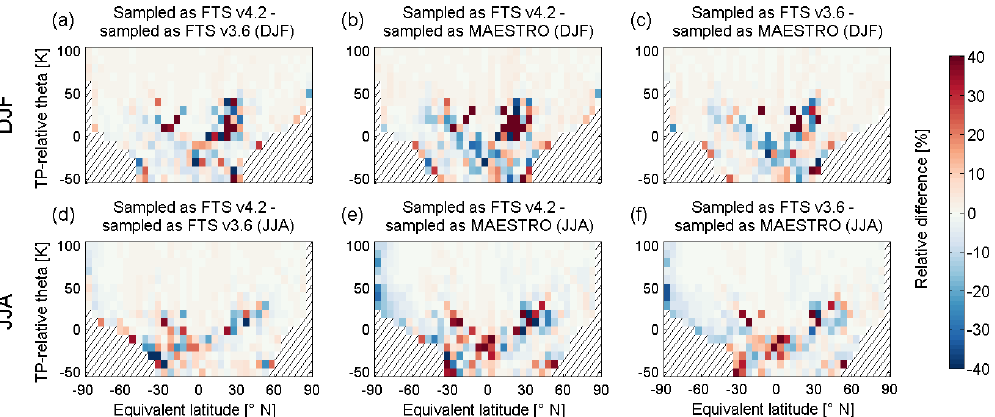
Figure 3. Intercomparisons of the CMAM39-SD model water vapour simulation, subsampled to the times and locations of the ACE- FTS v4.2, ACE-FTS v3.6, and MAESTRO measurements in order to assess the regions where the impact of the instruments’ sampling pattern is largest. Panels (a–c) correspond to the comparisons for DJF, while panels (d–f) show comparisons for JJA. Each plot title gives the two subsampled climatologies compared, with differences given as a relative difference (%). These differences are calculated as the first subsampled model climatology minus the second and divided by the average of the two. Note the addition of hatching to the plots where there are no data available. Table 1. Average magnitude of the relative differences ( | δr i,j | ) in water vapour between the model and measurement climatologies over select regions of the UTLS. The approximate vertical region is denoted alongside the vertical range, with UT standing for upper troposphere and LS for lower stratosphere. The regions reflect where the model displays consistently higher or lower water vapour than the instruments. Values are bold if the instrument climatology yields more water vapour than CMAM39-SD for that period. In addition, the last row shows the average magnitude of the relative difference averaged over the entire UTLS but is not presented in bold to reflect the differing behaviour over the entire region. Differences are provided for DJF and JJA. Region Instrument Latitude range Vertical range ACE-FTS v4.2 ACE-FTS v3.6